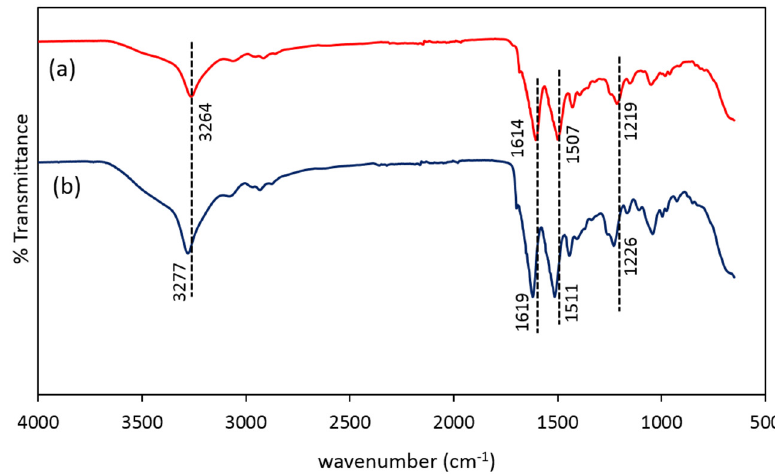
Figure 4. Fourier transform infrared spectroscopy (FTIR) spectra ( a ) original silk; and ( b ) SS-AgNP finished silk. Coatings 2017 , 7 , 145